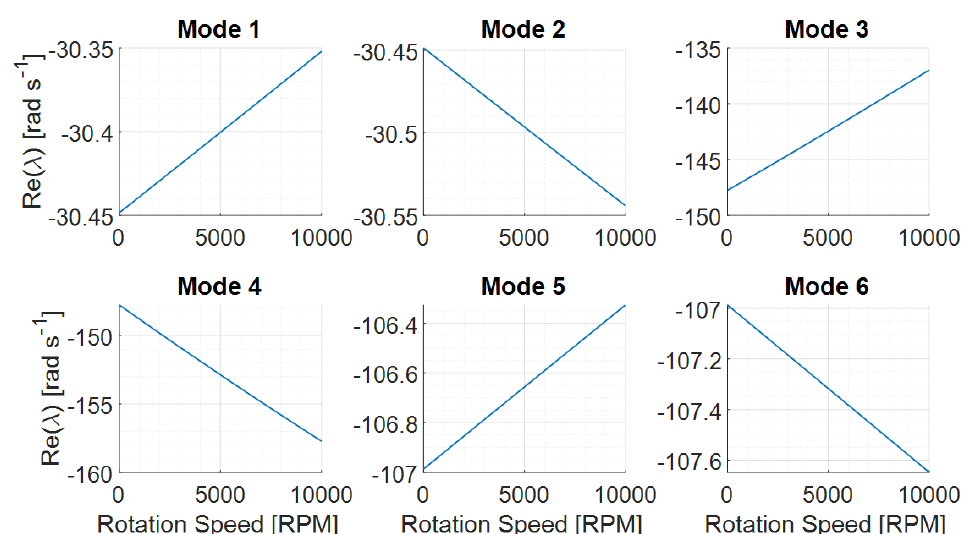
Figure 8. Stability of the first 6 resonance frequencies over the speed range. Negative real parts indicate stable behaviour. The stiffness and damping are set as described in Table 2.